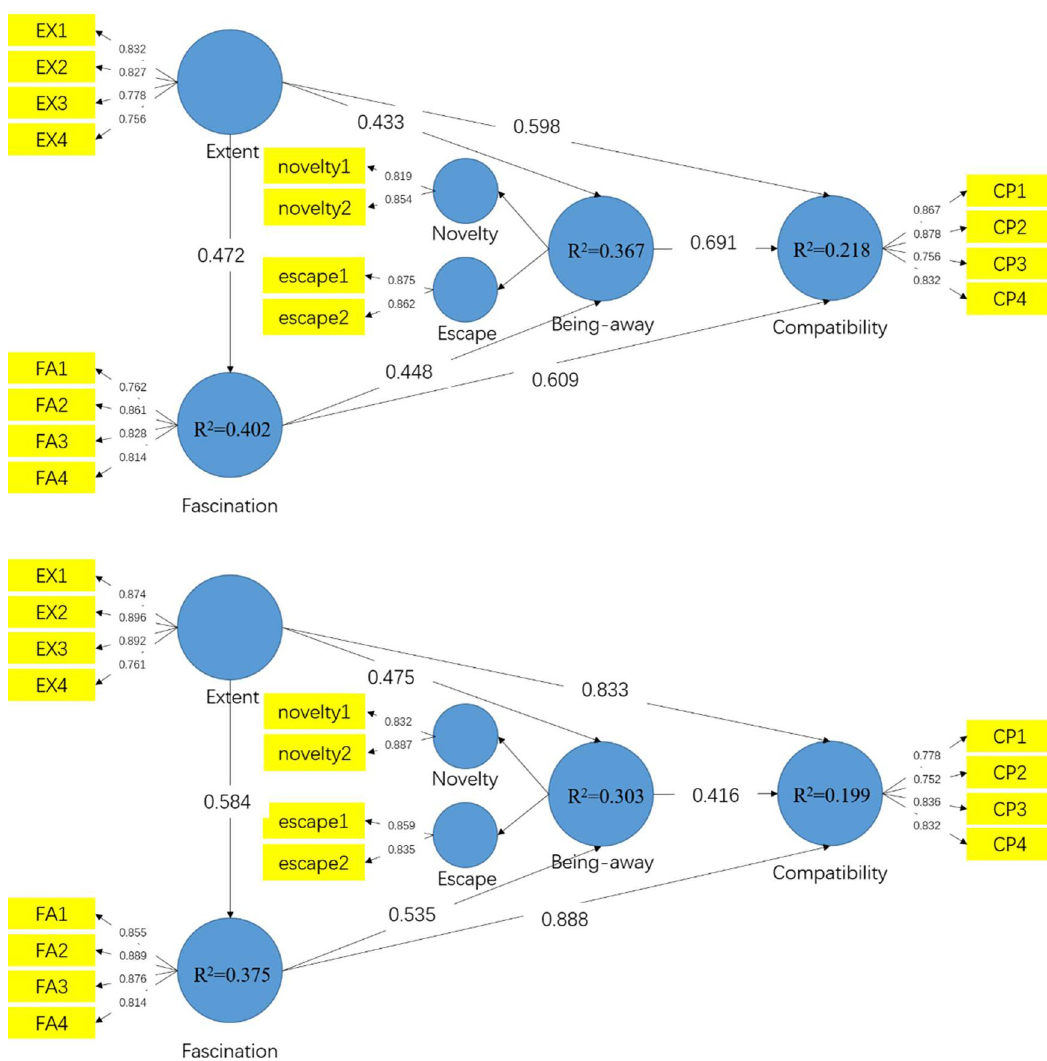
Fig 4. a . Results of the structural model for the pre-COVID-19 group. b . Results of the structural model for the post-COVID-19 group.